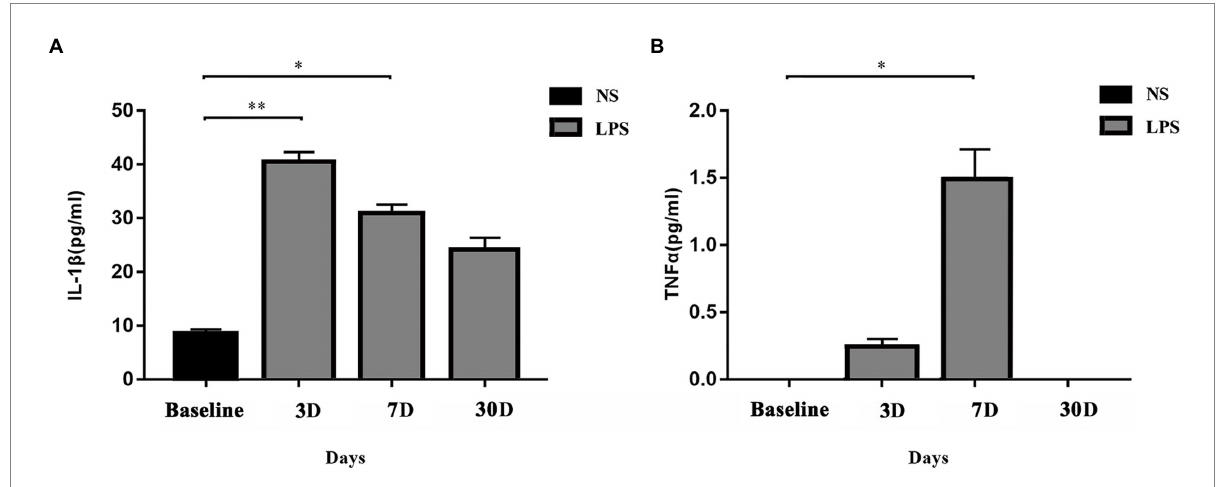
FIGURE 3 Systemic inflammatory responses. (A) IL-1 β level was significantly elevated on day 3 and day 7 in rats exposed to lipopolysaccharide (LPS) as compared with rats treated with normal saline (NS). (B) TNF α level was significantly elevated on day 7 in rats exposed to LPS as compared with rats treated with normal saline NS. Data were presented as mean ± standard error of mean (SEM). * p < 0.05, ** p < 0.01 vs. control group.